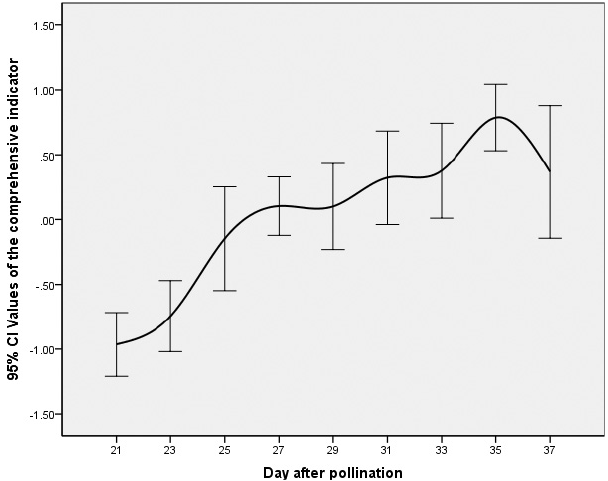
Fig. 10. Change of the comprehensive indicator with error bars of 95% con¯dence interval during ripening period of